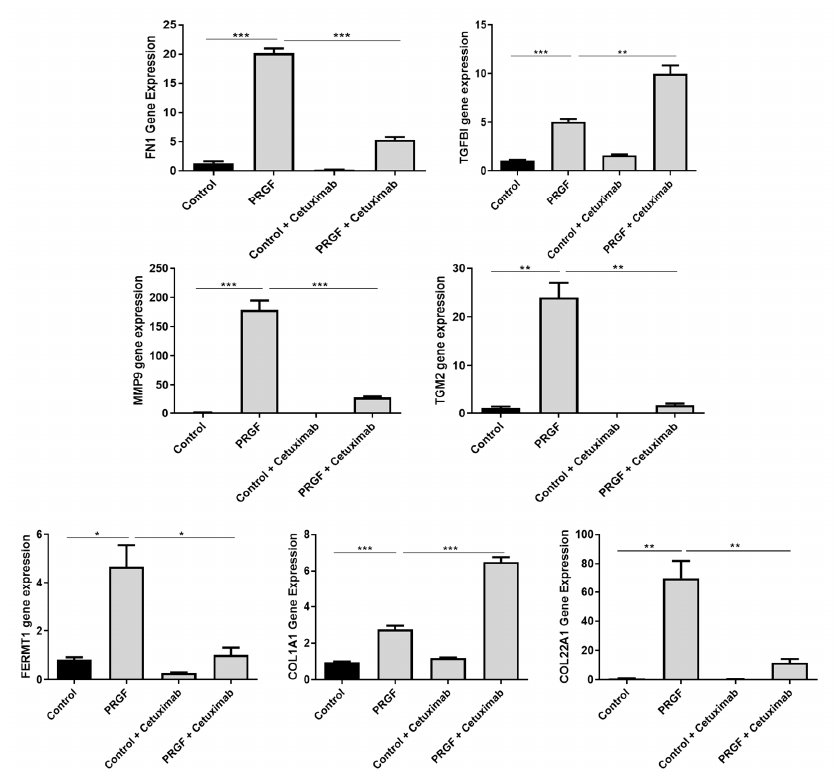
Figure 4. The epidermal growth factor receptor (EGFR) differentially influences the PRGF-induced expression of ECM-related proteins in human keratinocytes. Human primary keratinocytes were stimulated for 20 h with PRGF in the presence or absence of the EGFR blocking antibody cetuximab. Relative gene expression was analyzed by real-time PCR. Shown are means ± s.e.m of three stimulations (* p < 0.05, ** p < 0.01, *** p < 0.001; Student’s t -test).